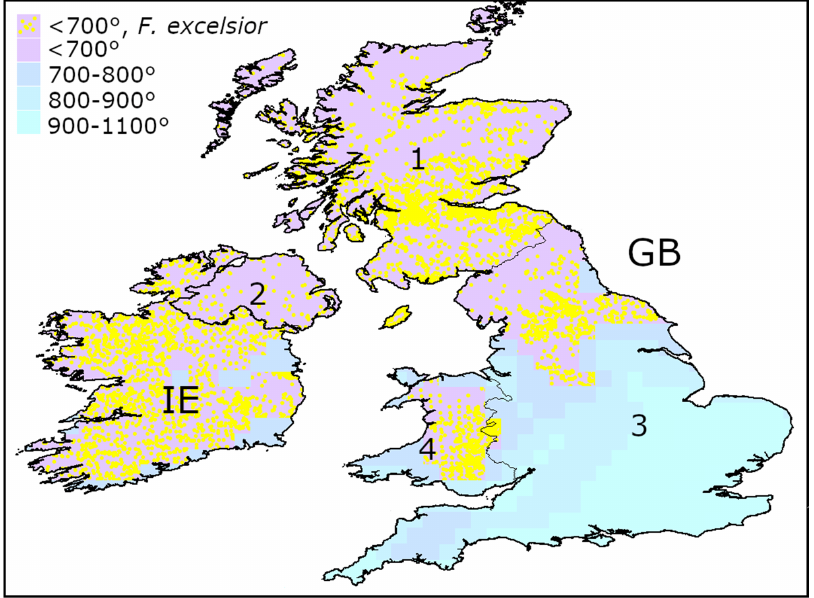
Figure 8. Occurrences of Fraxinus excelsior in the territories with AGDD 10 below 700° in British Isles. GB—Great Britain, IE—Ireland. 1—Scotland, 2—Northern Ireland, 3—England, 4—Wales. Mean AGDD 10 per year in 2003–2020 is indicated with colours (see the legend). The information about the occurrences of F. excelsior was obtained from Global Biodiversity Information Facility [33–36].